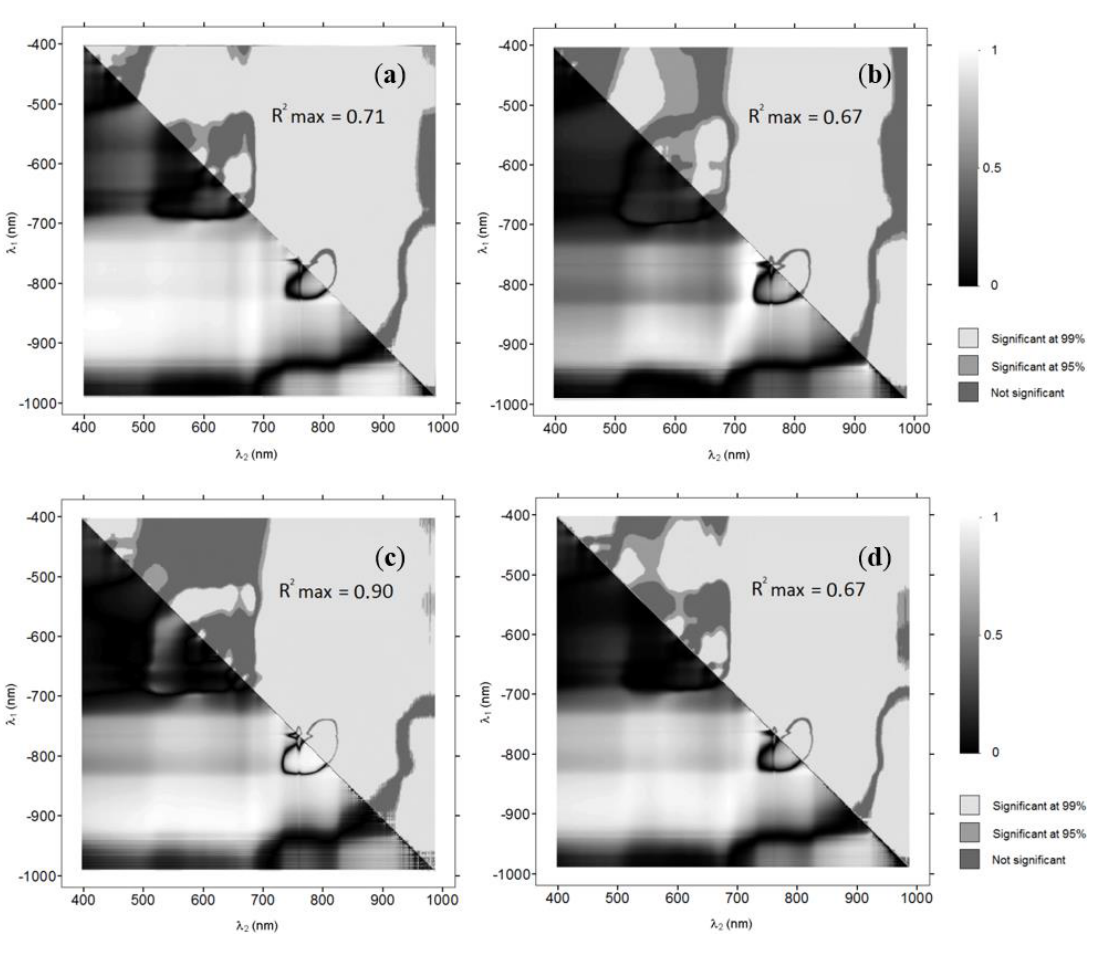
Figure 3. Optimal Band Ratio Analysis (OBRA) plots showing strength of image band ratio—depth associations for ( a ) Water Milfoil, ( b ) Pondweed, ( c ) Water Crowfoot, ( d ) all species. Bottom half R 2 -values; top half 99% significance level (light-grey) and 95% significance level